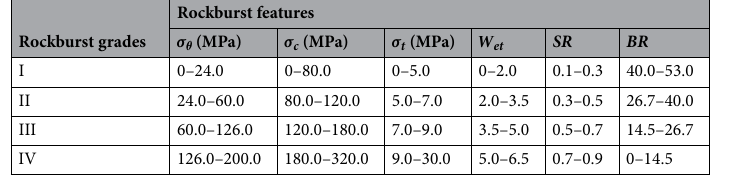
Table 2. Rockburst classification